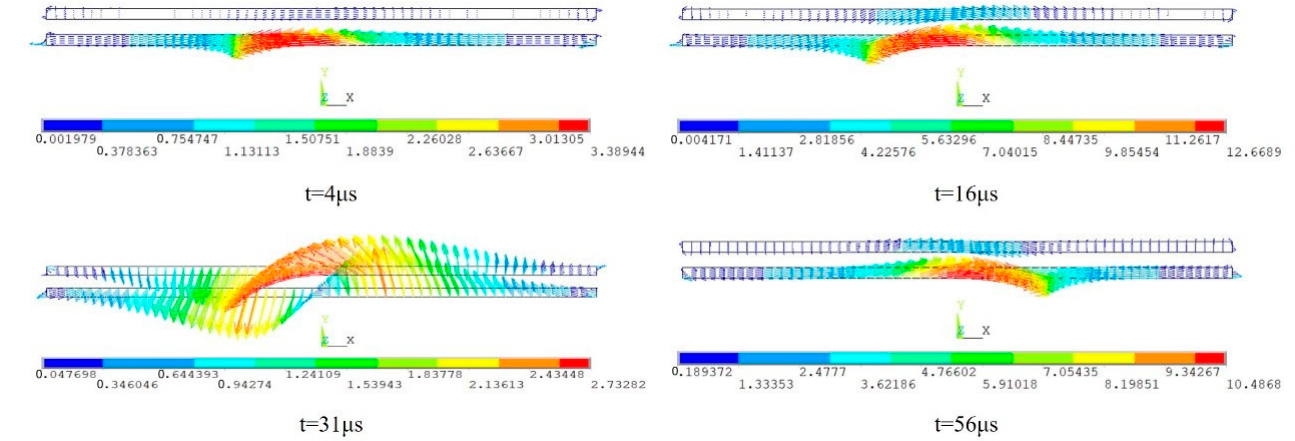
Figure 10. Distribution of magnetic induction intensity at typical moments.